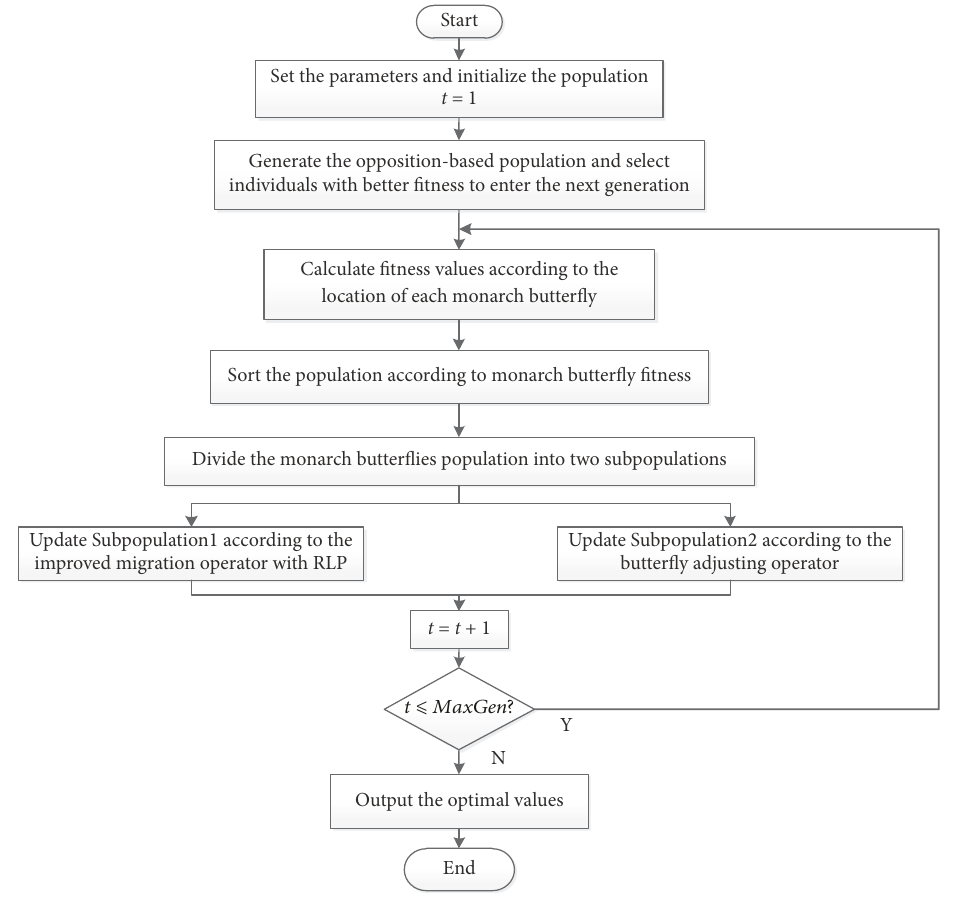
Figure 1: The main process of the OPMBO